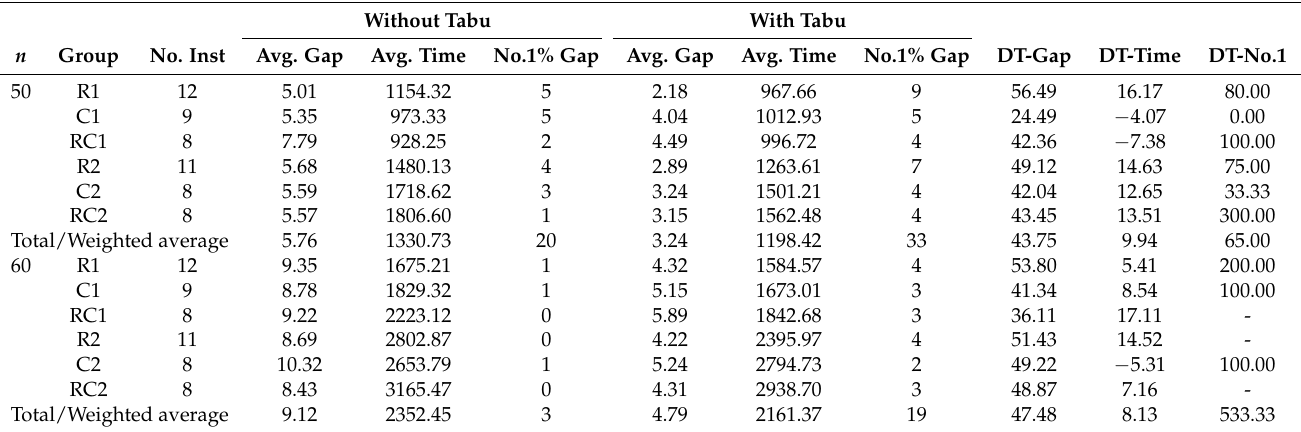
Table 2. Performance of tabu search algorithm for n = 50 and